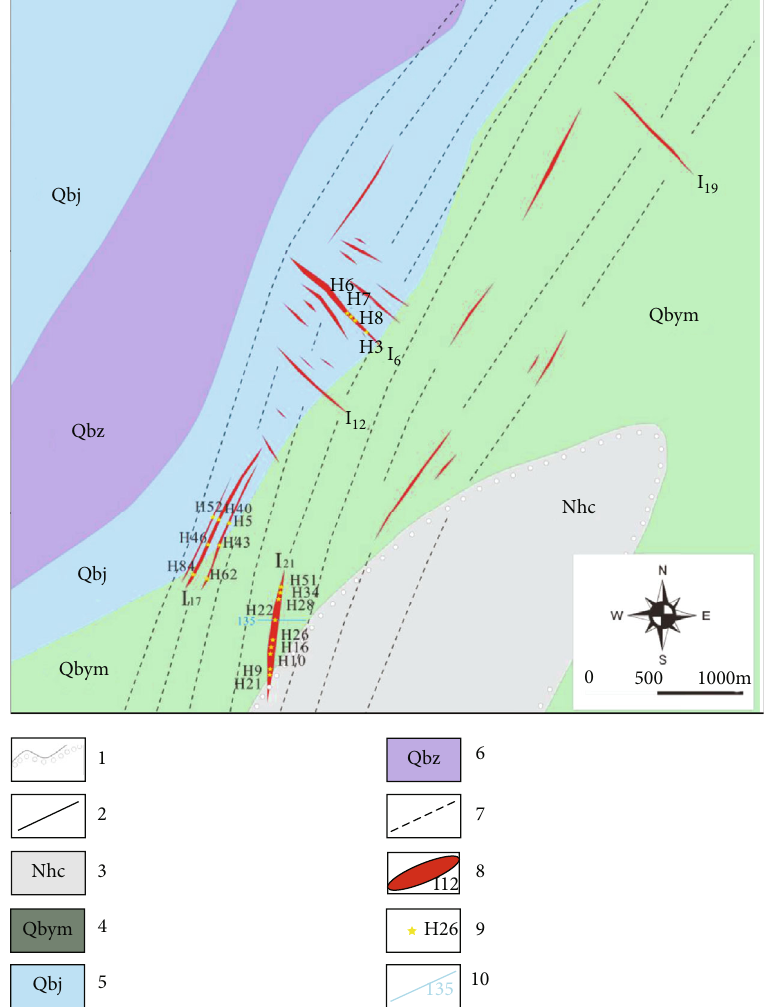
Figure 2: Geological sketch map of the Daping gold deposit (modi fi ed after [59]): 1: unconformity boundary; 2: conformity boundary; 3: Changan Formation (Nhc); 4: Yanmenzhai Formation (Qbym); 5: Jiajiantian Formation (Qbj); 6: Zhuanqiangwan Formation (Qbz); 7: ductile-brittle shear zone; 8: auriferous vein; 9: sample location; 10: prospecting line. Due to all the samples coming from diamond drills, only the horizontal positions are